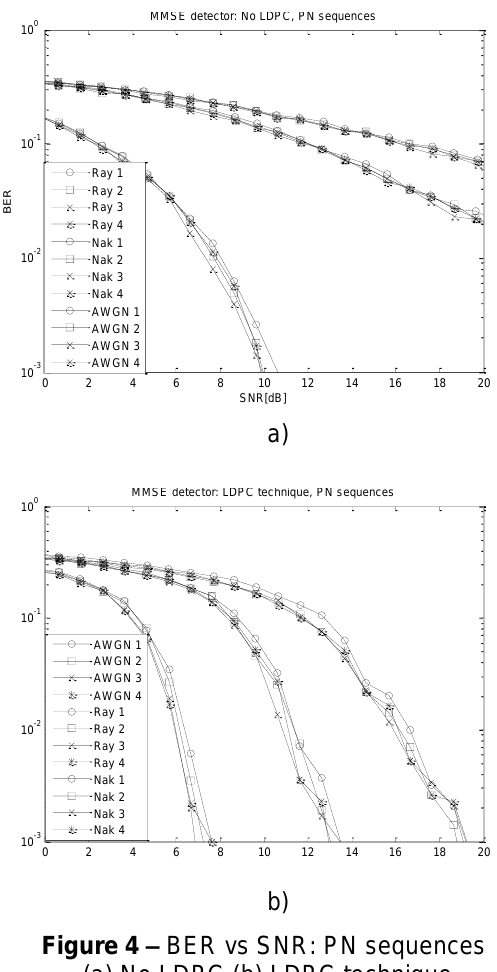
Figure 4 – BER vs SNR: PN sequences (a) No LDPC (b) LDPC